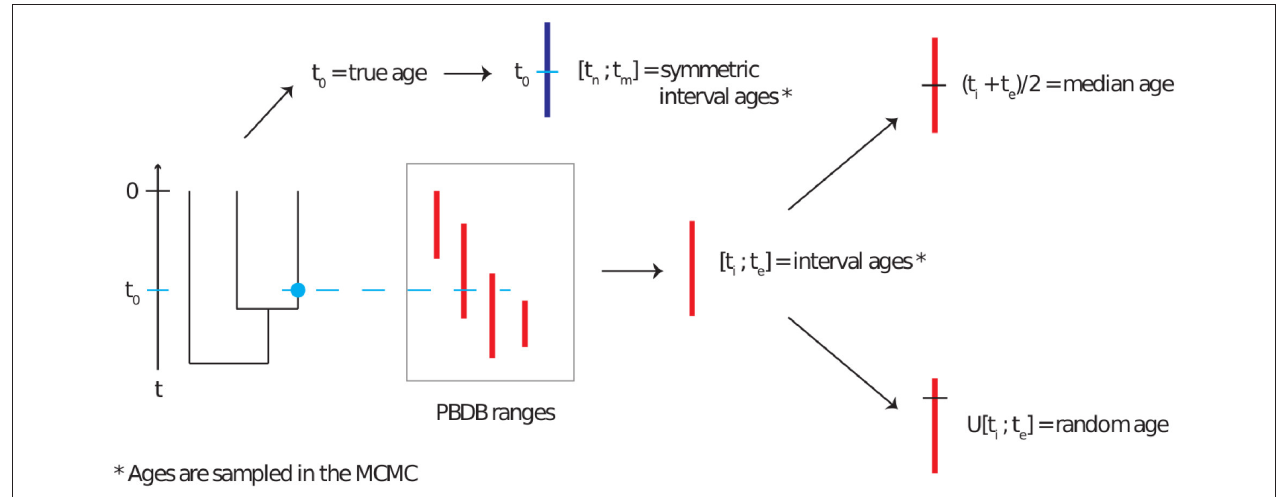
FIGURE 1 | Representation of the age uncertainty simulation process, reproduced from Barido-Sottani et al. (2019a). Phylogenies with fossils are simulated according to a birth-death-fossilization process. The correct age of each fossil is used to draw an age interval for that fossil from the set obtained from PBDB. This age interval is then used as the basis for the median and random age assignment. A symmetric age interval is also drawn from the correct